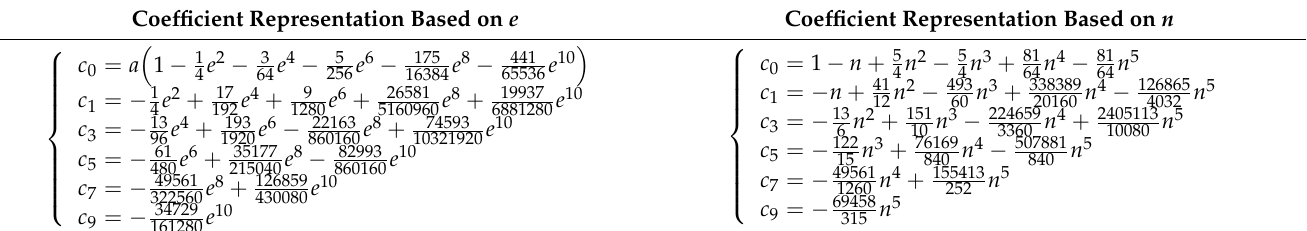
Table 4. Coefficients in Equation